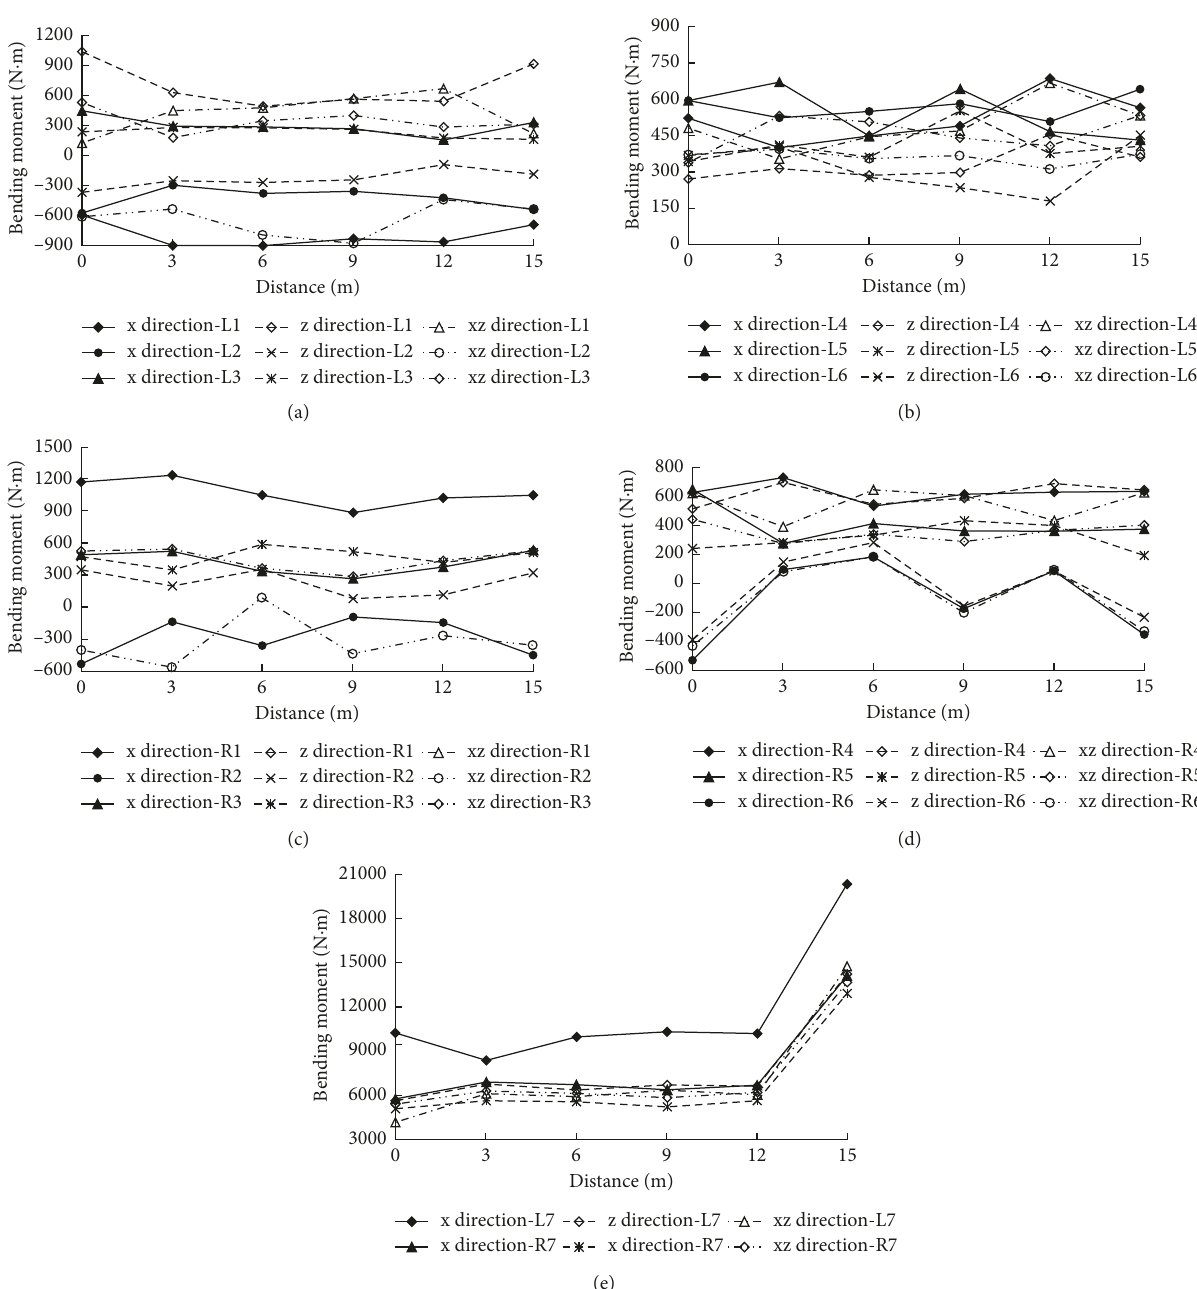
Figure 10: The bending moment of tunnel lining along longitudinal